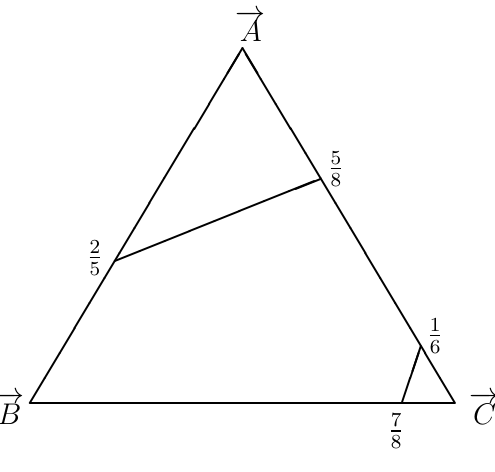
Figure 3 . The best response regions in Young’s